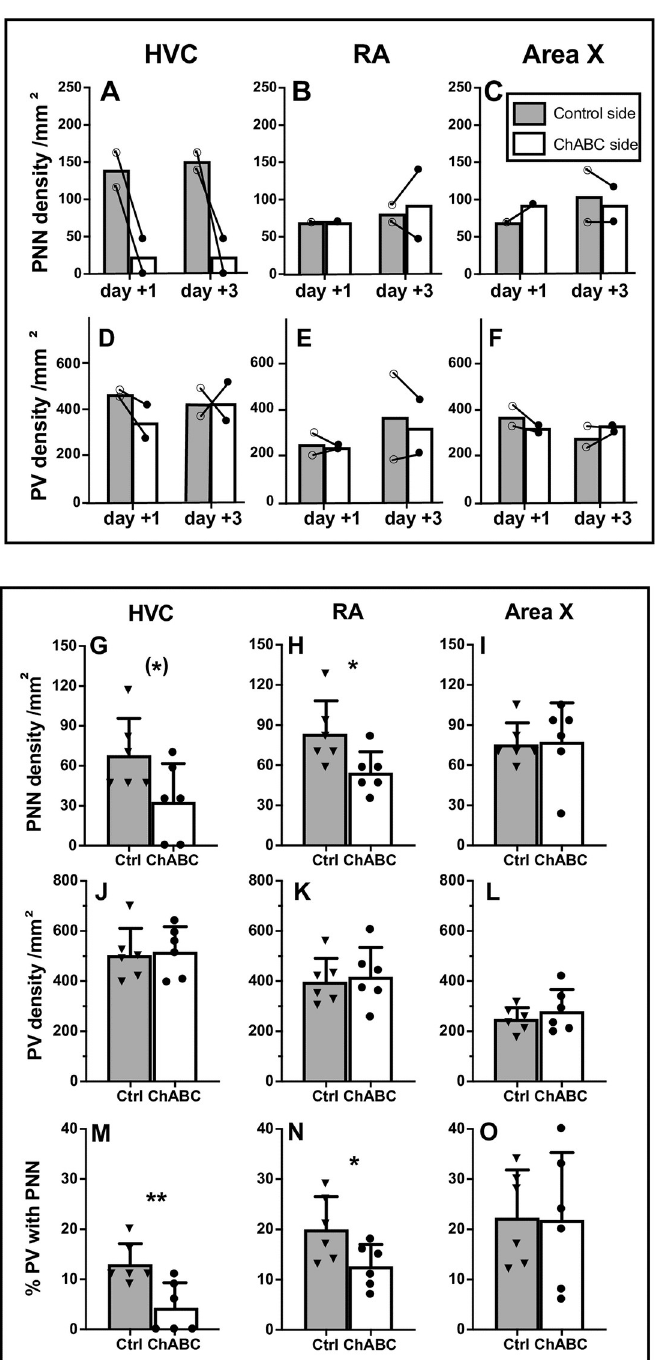
Fig 6. Effects of chondroitinase ABC (ChABC) on PNN in the song control nuclei of male canaries. A-C: density (numbers per mm 2 ) of PNN and of PV in HVC (A, D), RA (B, E) and Area X (C, F) in the control (grey bars) and ChABC (open bars) hemisphere of canary brains treated unilaterally and collected 1 or 3 days after the surgery. Individual values are indicated by empty (Ctrl) or full (ChABC) dots. Connected dots represent the two hemispheres of the same bird. Bars represent the mean of each group. G-O : density of PNN (G-I), density of PV-positive cells (J-L), and % PV with PNN (M-O) in HVC, RA and Area X of Ctrl (grey bars) and bilaterally ChABC-treated (open bars) birds that were used to analyze singing behavior. Brains were collected one month after the treatments. Bars represent the means ± SEM and individual values are indicated by dots or triangles. T-test were used to compare groups and significant differences are indicated as follow ( � ) p < 0.10, � p <